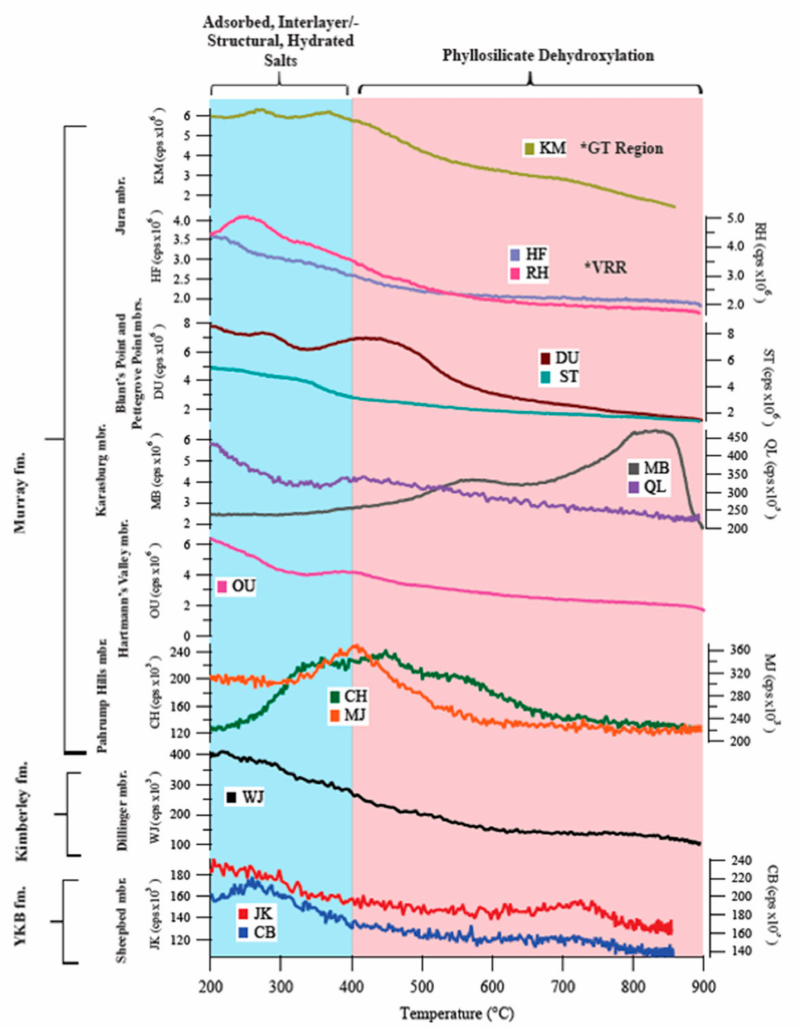
Figure 11. SAM H 2 O EGA results for samples grouped by stratigraphic members. The dehydration temperature ranges of H 2 O for adsorbed and interlayer water are highlighted in blue, and the dehydroxylation temperature ranges for phyllosilicates are highlighted in